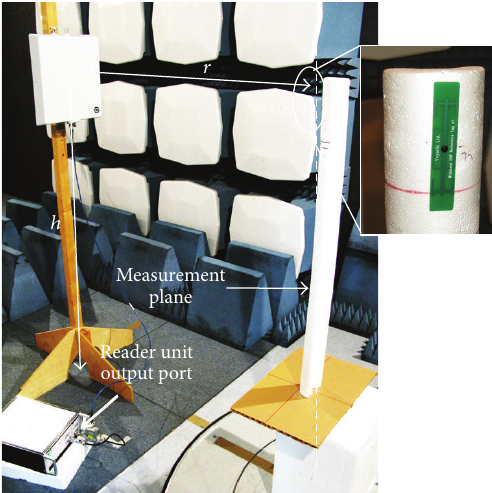
Figure 5: Channel characterization in anechoic chamber environ- ment for the upper arm case. The calibration tag is polarization- matched with the linearly (vertical) polarized reader antenna and located at the measurement plane in the far-field.